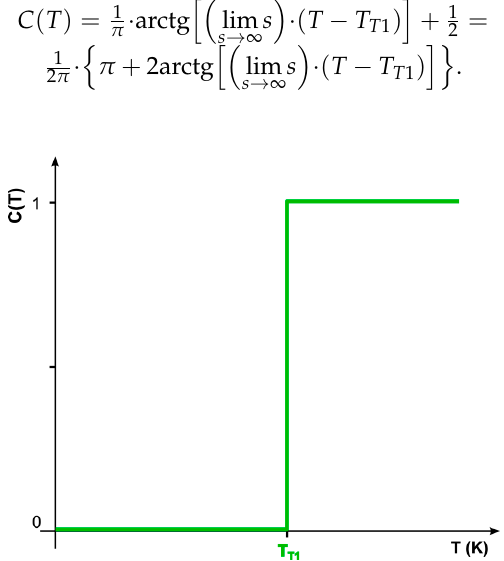
Figure A2. Function C ( T ).